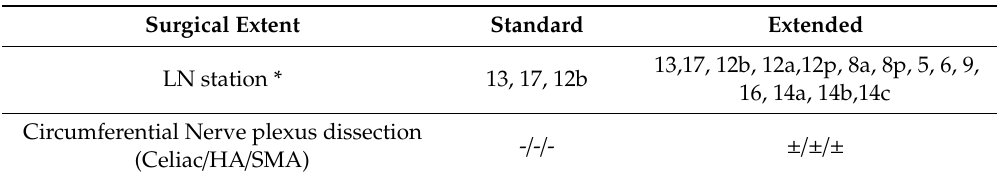
Table 1. Topographic di ff erences in extent of lymph node dissection between standard pancreaticoduodenectomy (PD) and extended PD. Surgical Extent Standard Extended LN station * 13, 17, 12b